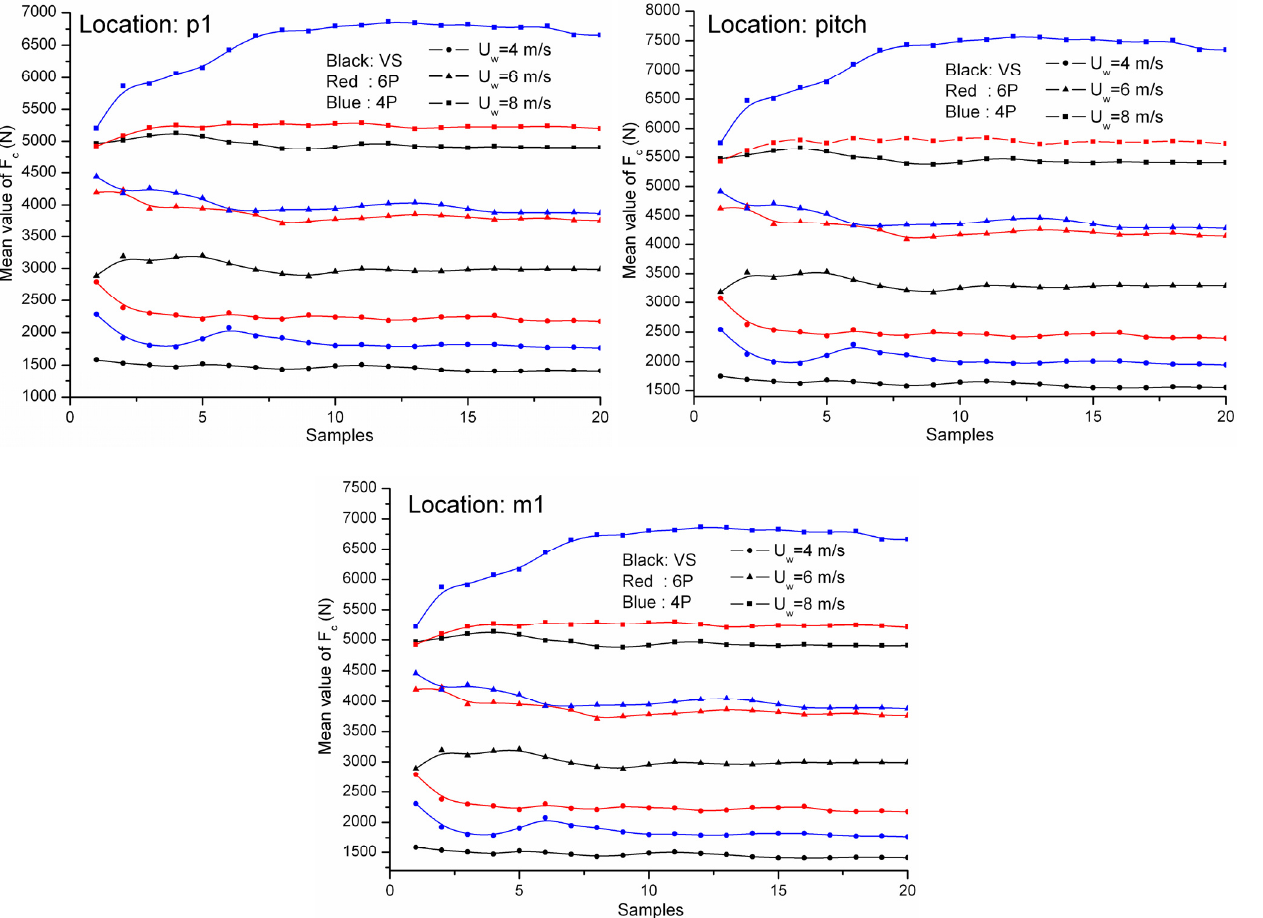
Figure 13. Variation of mean contact forces when using different generators at the different contact points, wind speeds and number of simulation